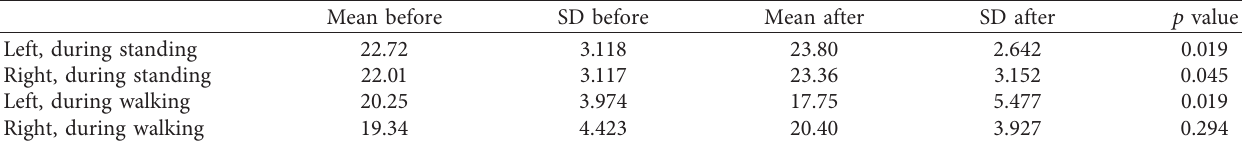
Table 1: Correlation coefficients between the level of TMJ acoustic abnormalities and the sacroiliac joint locks by sides and jointly. Variables Correlation coefficient p value Right acoustics and right locks 0.412 0.024 Left acoustics and left locks 0.489 0.006 General acoustics and the number of locked joints 0.562 0.001 Table 2: Differences in mean values of the AI before and after stabilizing the mandible in a new position using a temporary silicone occlusal splint. Mean before SD before Mean after SD after p value Left, during standing 22.72 3.118 23.80 2.642 0.019 Right, during standing 22.01 3.117 23.36 3.152 0.045 Left, during walking 20.25 3.974 17.75 5.477 0.019 Right, during walking 19.34 4.423 20.40